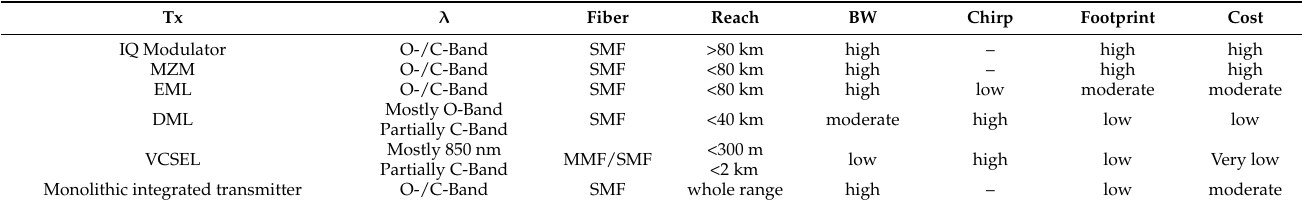
Table 6. Comparison of different transmitters applied in beyond 100-Gbit/s per lane data transmission.